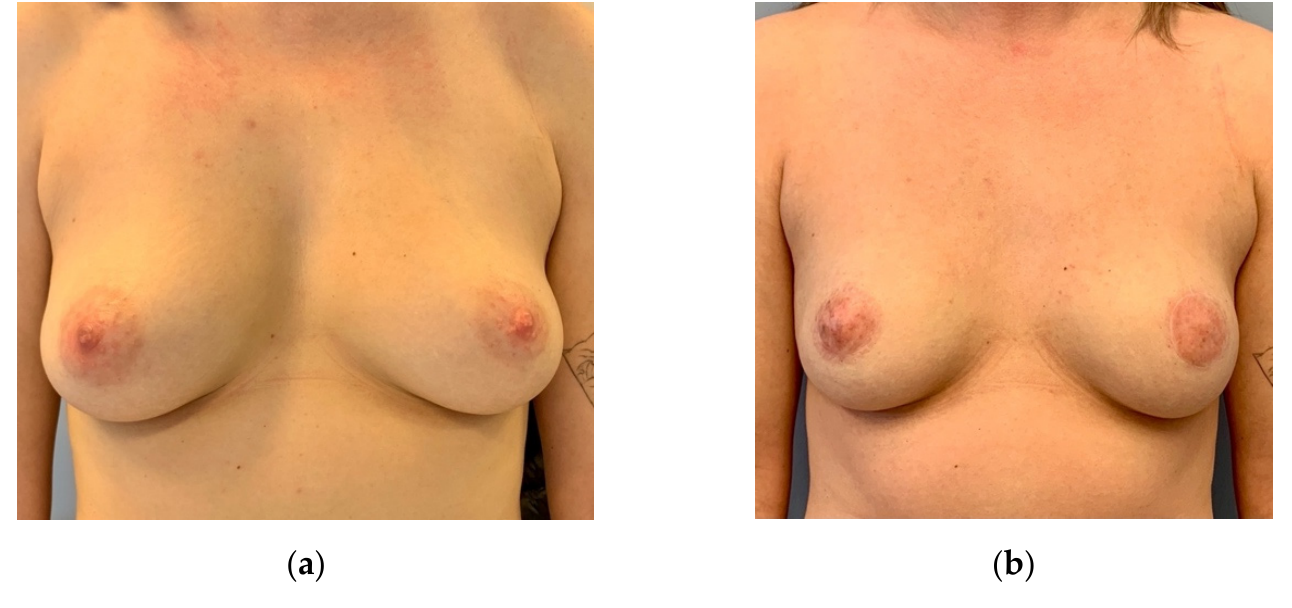
Figure 8. ( a ) Preoperative: 26-year-old patient with BRCA 1 mutation and slight asymmetry asking for risk-reducing mastectomy. ( b ) Five months after bilateral circumareolar mastectomy and recon- struction with bilateral inner thigh flaps and free NAC grafts. No other scars evident at the breasts apart from the circumareolar. Postoperative MRI reveals almost no residual glandular tissue.